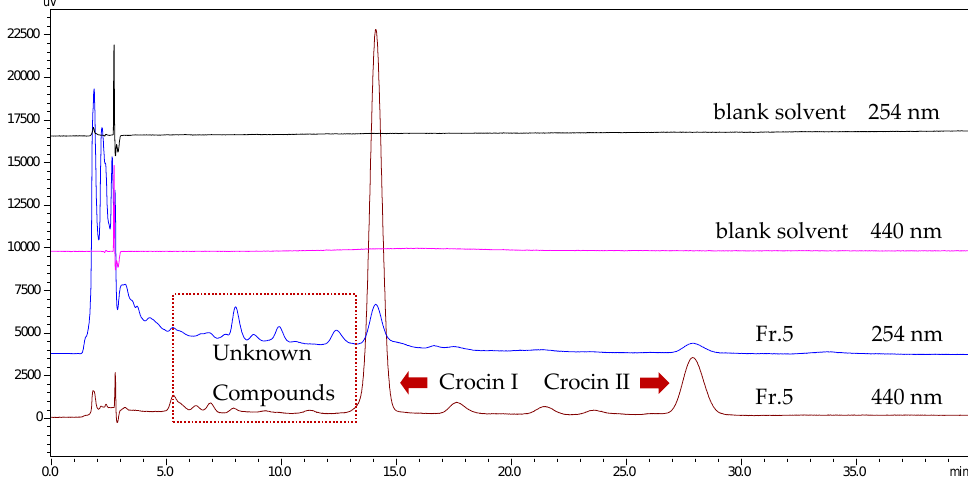
Figure 2. The HPLC chromatograms of Fr. 5.